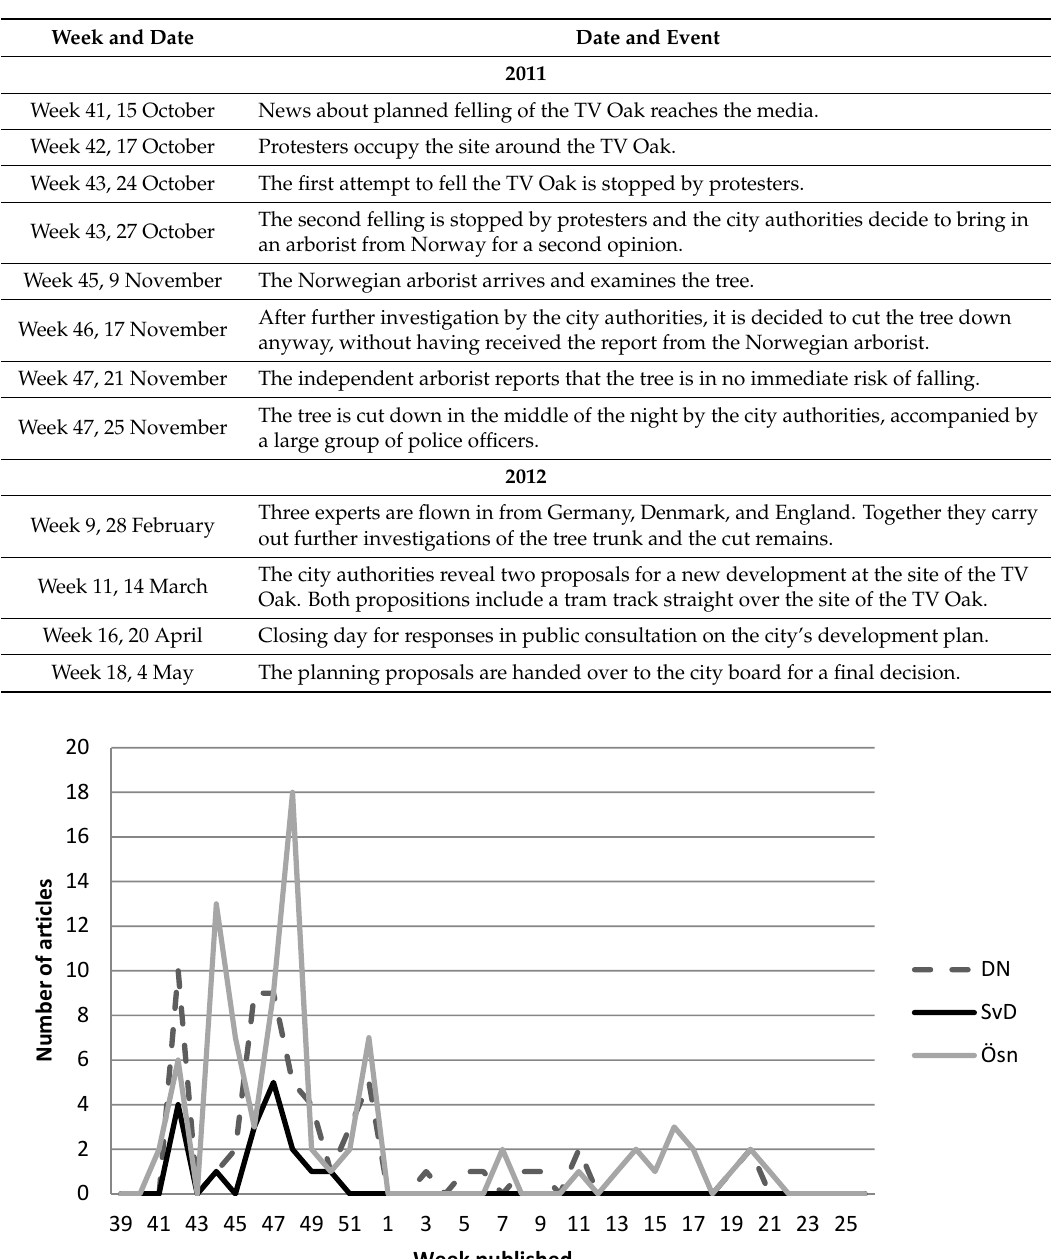
Table 2. Calendar week and date of important events surrounding media attention to the TV Oak.